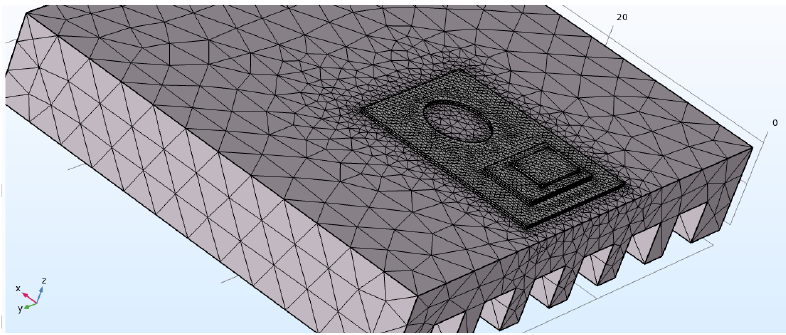
Figure 12. Assigned mesh for the 3D structure of the switch in FEM solutions. Table 4. Material specifications in the developed simulation model of